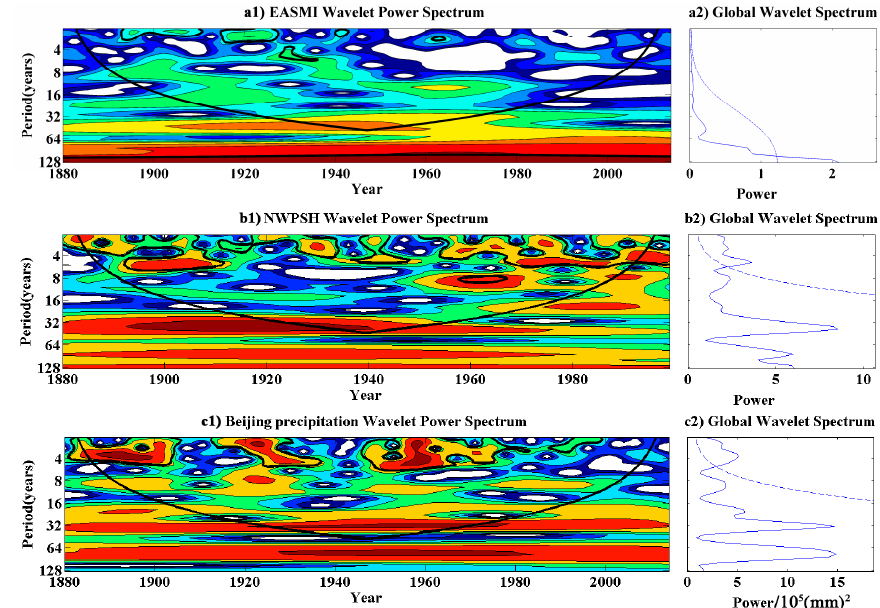
Figure 2. Continuous wavelet transform (( left ), red color means stronger power and blue means weakest power) and global wavelet spectrum ( right ) of East Asian Summer Monsoon index (EASMI) ( a ); Northern Limit of Western Pacific Subtropical High (NWPSH) ( b ); precipitation of the Beijing area ( c ).